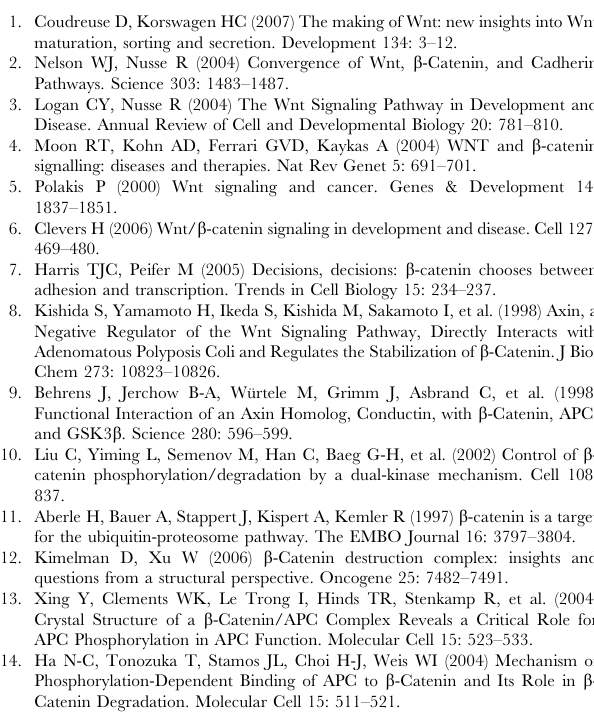
volumes (Calcein AM vs. Hoechst) showing population isolation and the cut-off volumes applied. (TIF) Figure S15 Cell population sizing and selection (SW480). Population statistics of SW480, showing the (A) histograms of normalised volume (Calcein AM/Hoechst); (B) Scatter plot of fluorescent marked volumes (Calcein AM vs. Hoechst) showing a good linear relationship; (C) Scatter plot of fluorescent marked volumes (Calcein AM vs. Hoechst) showing population isolation and the cut-off volumes applied. Text S1 Preparation and Purification of Recombinant